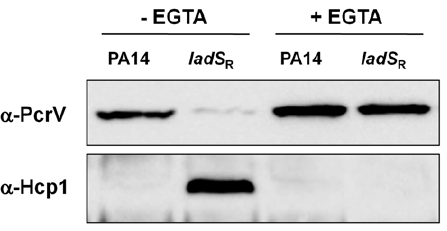
Figure 4. Immunoblots of PA14 and ladS R cell lysates using antibodies directed against structural components of the T3SS and T6SS (PcrV and Hcp1 respectively). The calcium chelator EGTA was added to the growth medium to induce the T3SS as indicated.